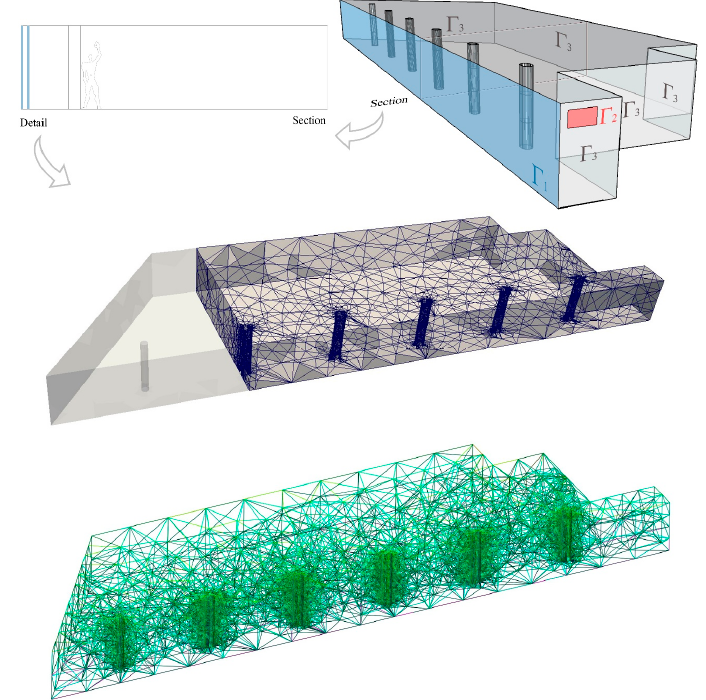
Figure 1. Plan of room and active transparent façade (ATF). Boundary labels for the problem (P room ) and details of the computational